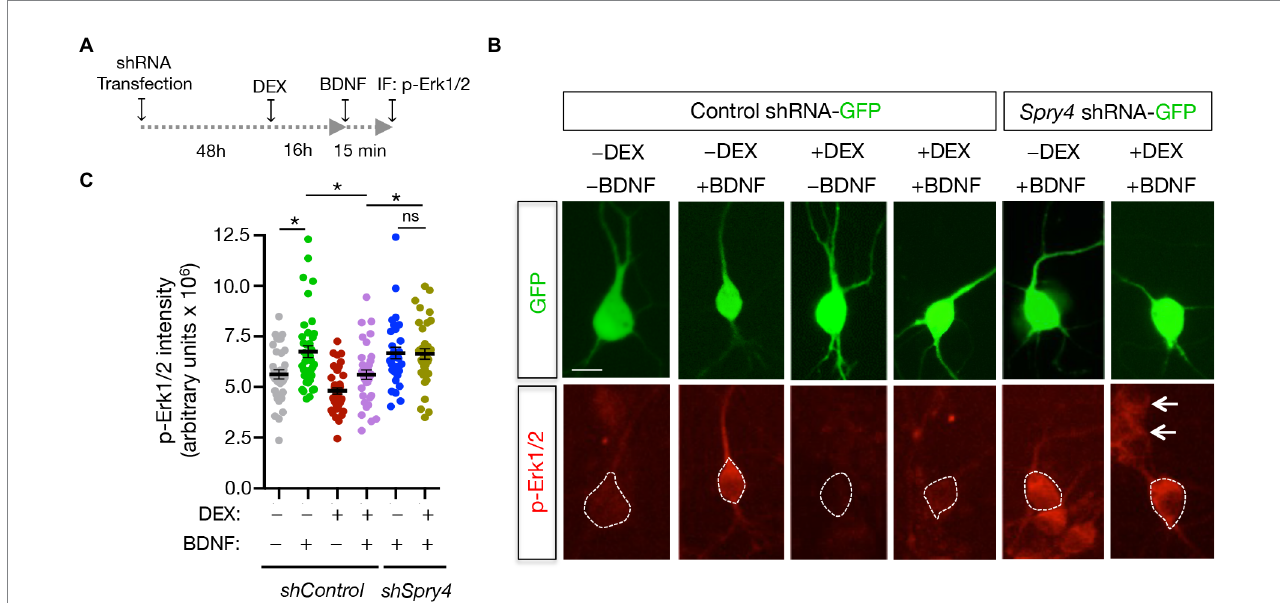
FIGURE 6 Sprouty4 mediates the inhibitory effect of DEX on BDNF-induced Erk1/2 phosphorylation in hippocampal neurons. (A) Experimental scheme used to measure Erk1/2 phosphorylation (p-Erk1/2) in response to DEX and BDNF treatments. Hippocampal neurons were transfected at DIV3 with control-shRNA- GFP or Sprouty4 -shRNA-GFP plasmids. (B) Photomicrographs show hippocampal neurons transfected with control-shRNA-GFP or Sprouty4 -shRNA-GFP plasmids. Neurons were pretreated or not with DEX for 16 h, stimulated for 15 min with BDNF (25 ng/mL) and then fixed with 4% PFA containing phosphatase inhibitors. Activation of Erk1/2 was assessed by immunofluorescence (IF) of phospho-Erk1/2 (p-Erk1/2) on GFP-positive cells labeled with dotted lines. Arrows indicate neighboring non-transfected cells. Scale bar, 20 μ m. (C) Graph showing individual values of p-Erk1/2 activation expressed as arbitrary units.